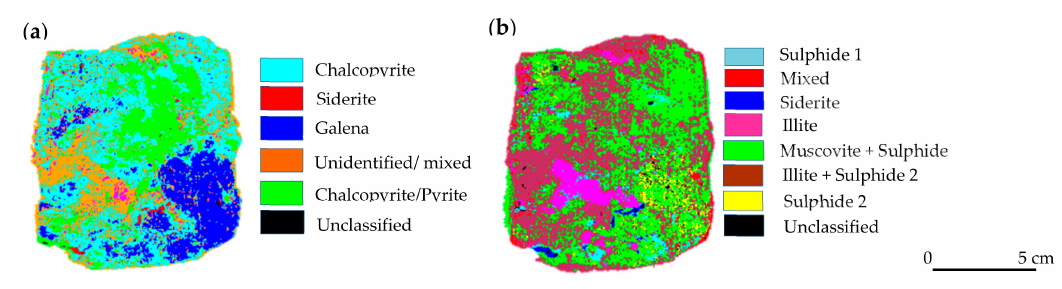
Figure 7. Examples of the classified images of ( a ) VNIR and ( b ) SWIR image data taken using the same sample.